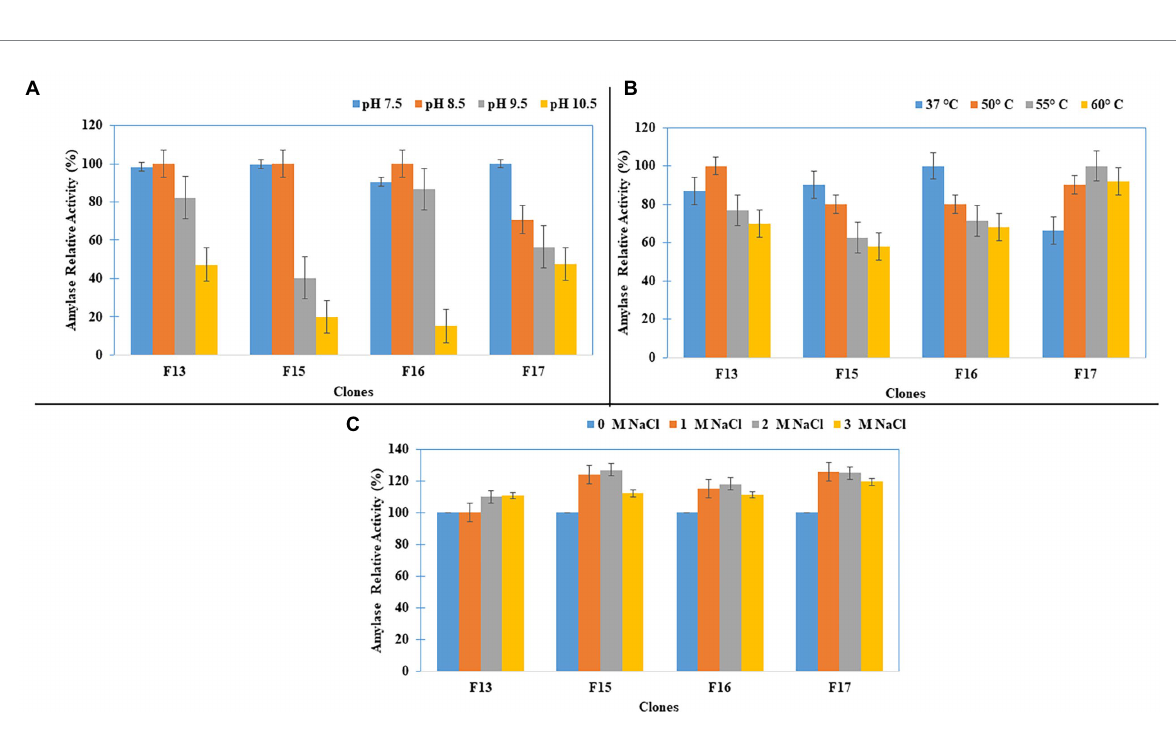
FIGURE 4 Amylase Activity characterization of the clones for (A) pH, (B) Temperature, and (C) Salt